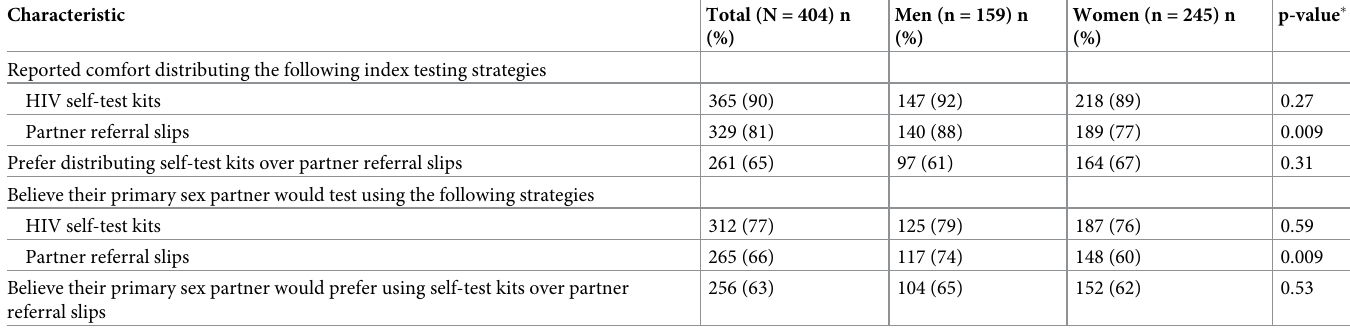
Table 2. Acceptability and feasibility of index HIVST by HIV-positive clients vs. partner referral slips by sex (n = 404).